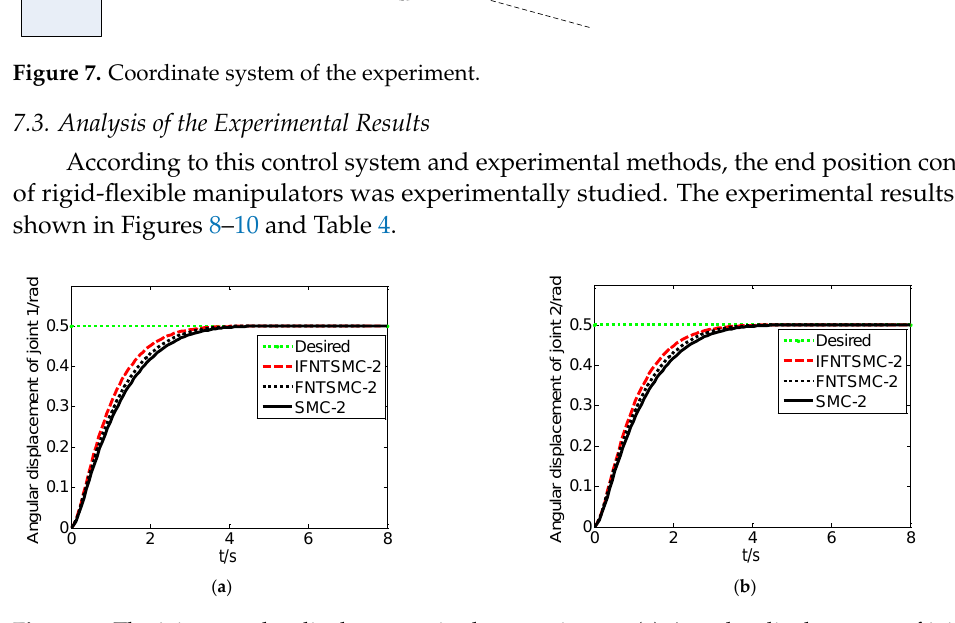
Figure 8. The joint angular displacement in the experiment. ( a ) Angular displacement of joint 1, ( b ) Angular displacement of joint 2.